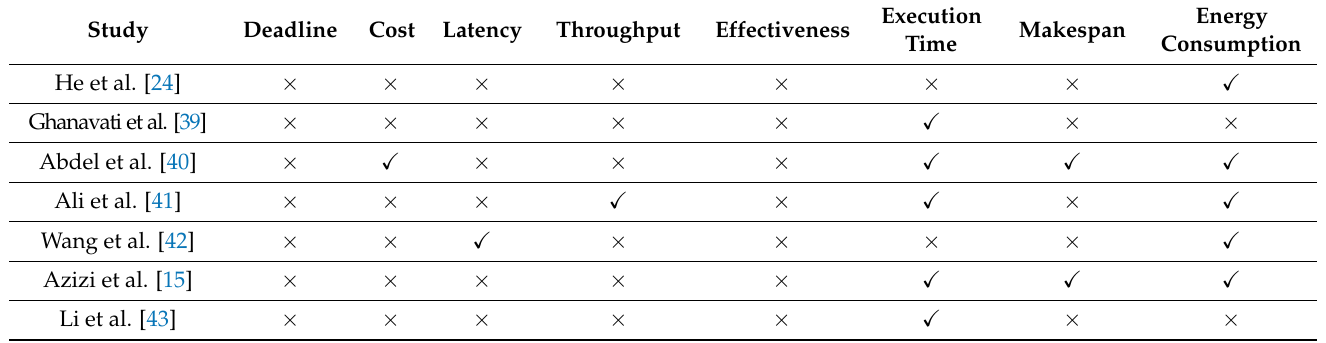
Table 17. Analysis of articles in terms of evaluation parameters in energy efficiency